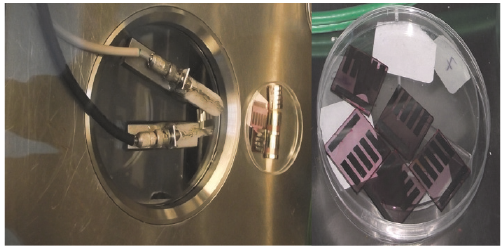
Figure 4: Organic cells used for